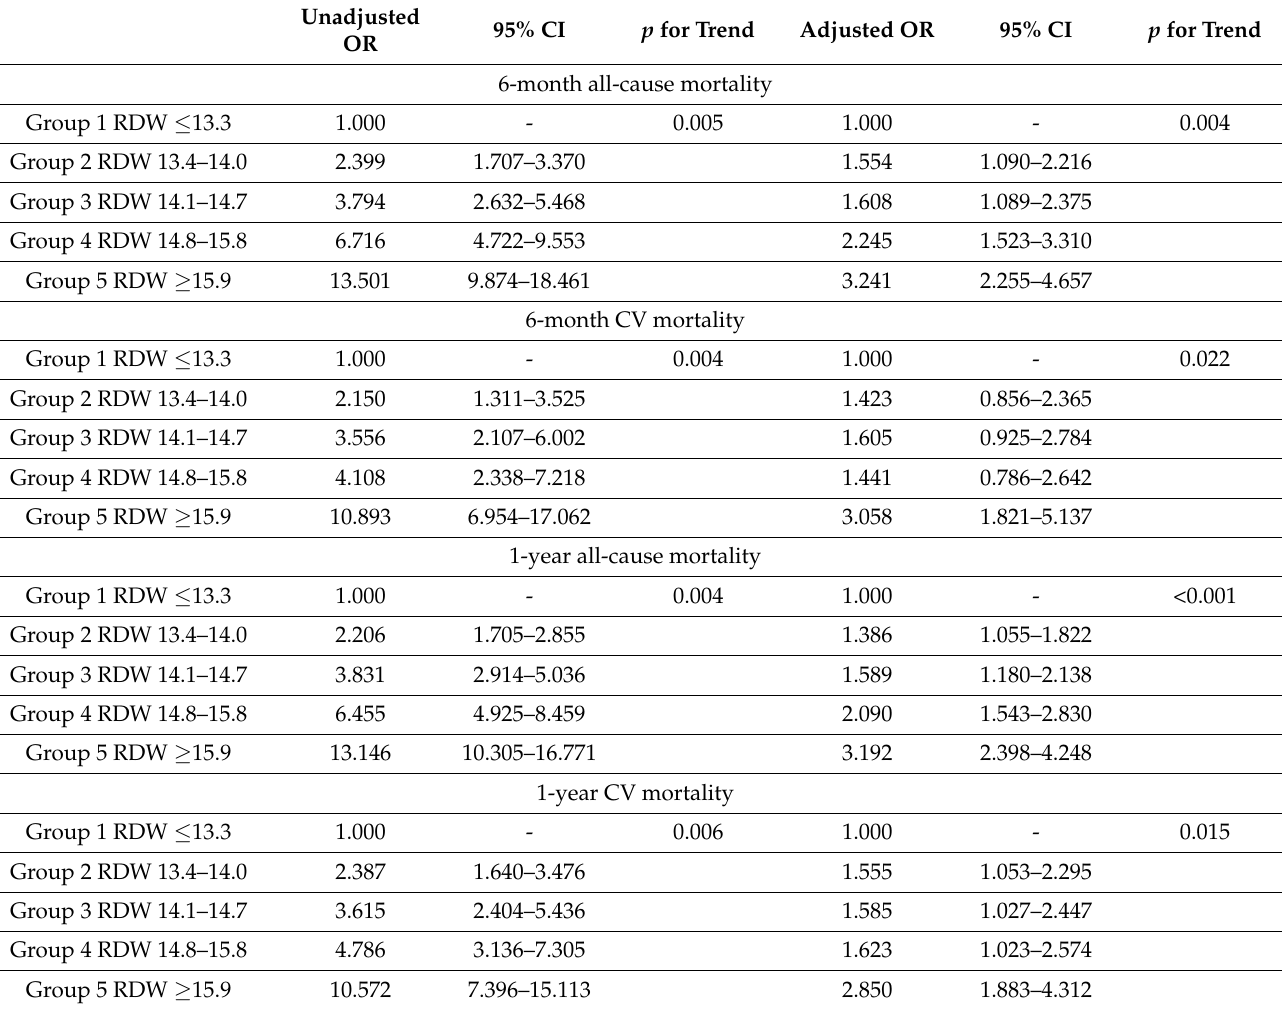
Table 3. Multivariable Logistic Regression Analysis for Mortality Outcome of Study